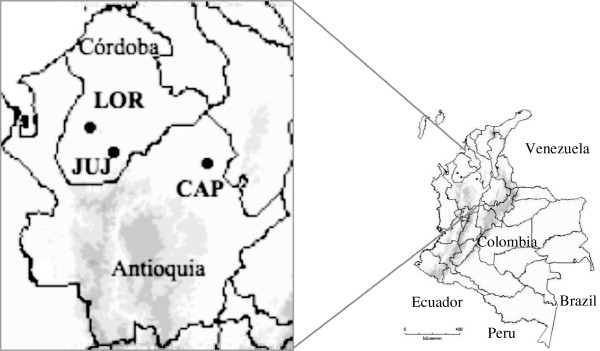
Collection sites. UCS region. El Loro-LOR and Juan Jose-JUJ, Córdoba Department and La Capilla-CAP, Antioquia Department.